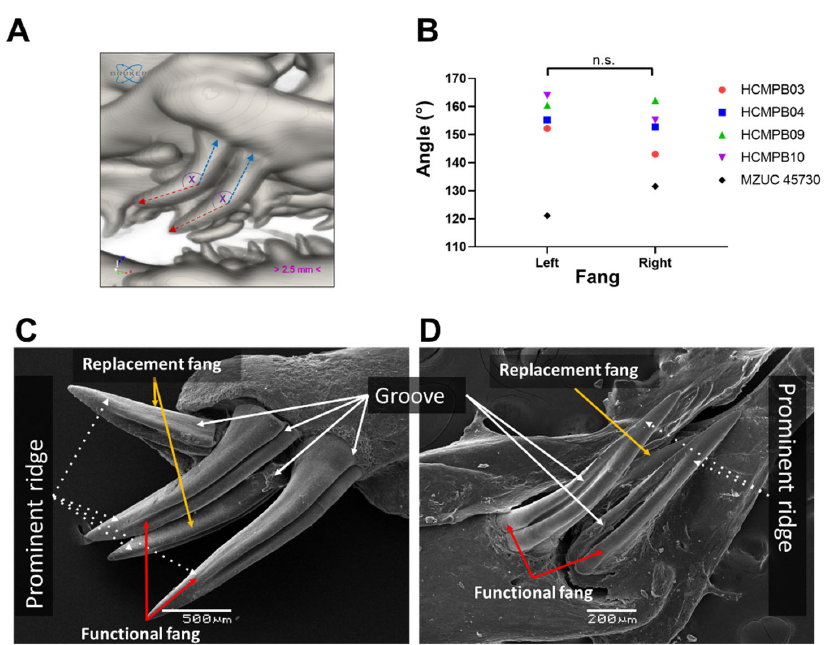
Figure 7. Anatomical and structural characteristics of the fang of Galvarinus ch. chilensis . ( A , B ) MicroCT image detailing the anatomical orientation and angle of fangs (adult, MZUC 45,730). SEM images show grooves and prominent ridges in ( C ) adult (MZUC 11,658) and ( D ) juvenile (MZUC 45,310) specimens. Abbreviation: n.s.: not significant.